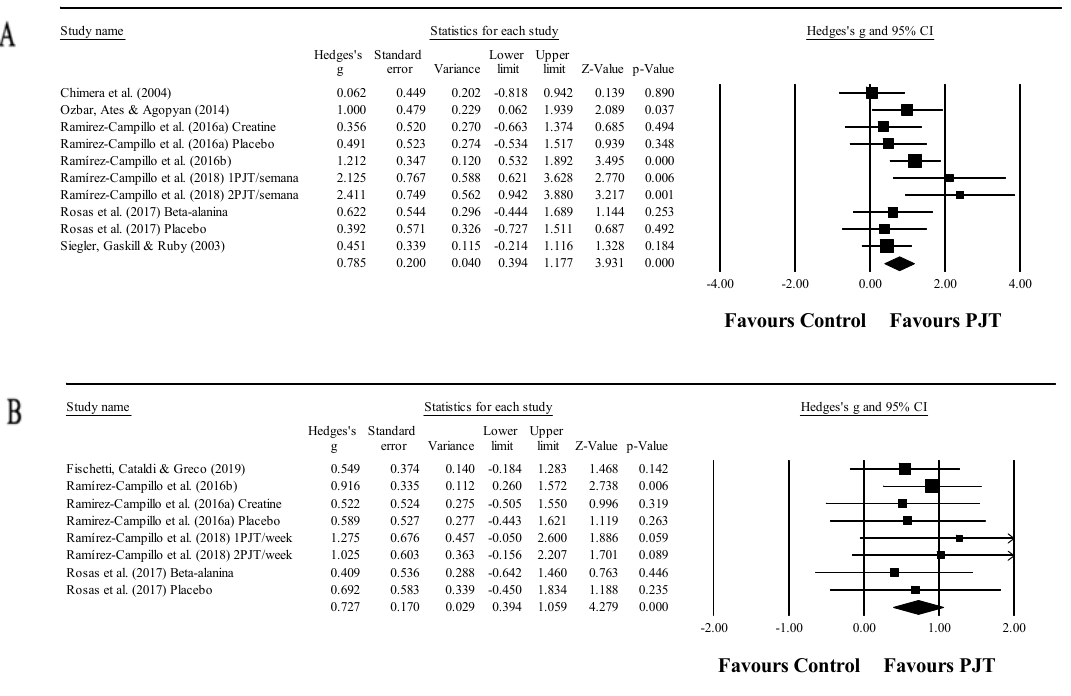
Figure 4. Forest plot of changes in linear sprint performance ( A ) (upper) and change of direction speed performance ( B ) (bottom), in athletes participating in plyometric jump training (PJT) compared to controls. Values shown are effect sizes (Hedges’s g) with 95% confidence intervals (CI). The size of the plotted squares reflects the statistical weight of the study.